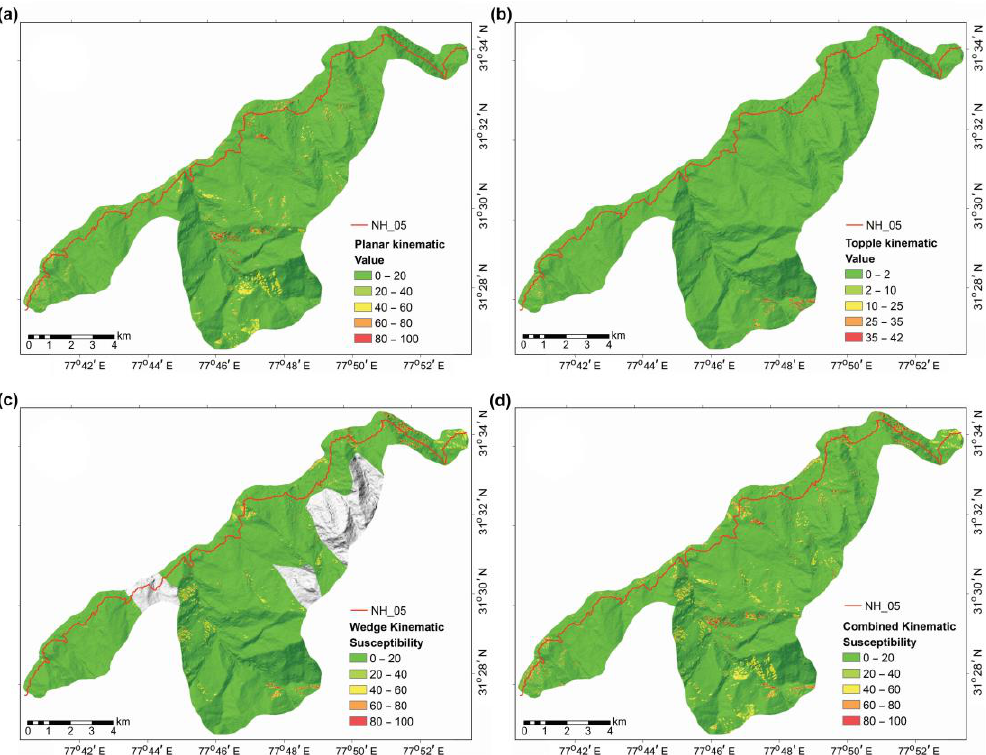
Figure 9. Kinematic susceptibility results (maximum value out of all the layers at each pixel) from the combined effect of all joint sets for ( a ) planar failure susceptibility; ( b ) topple failure susceptibility; ( c ) wedge failure susceptibility; ( d ) all modes of failure (combined) susceptibility.